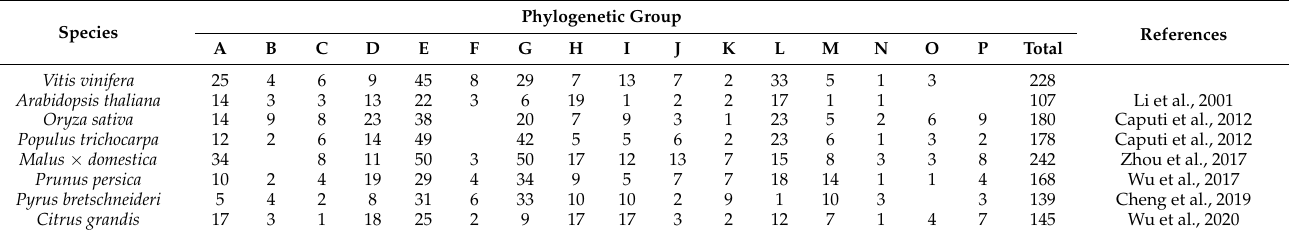
Table 1. Number of UGT members in model plants and different fruit trees.